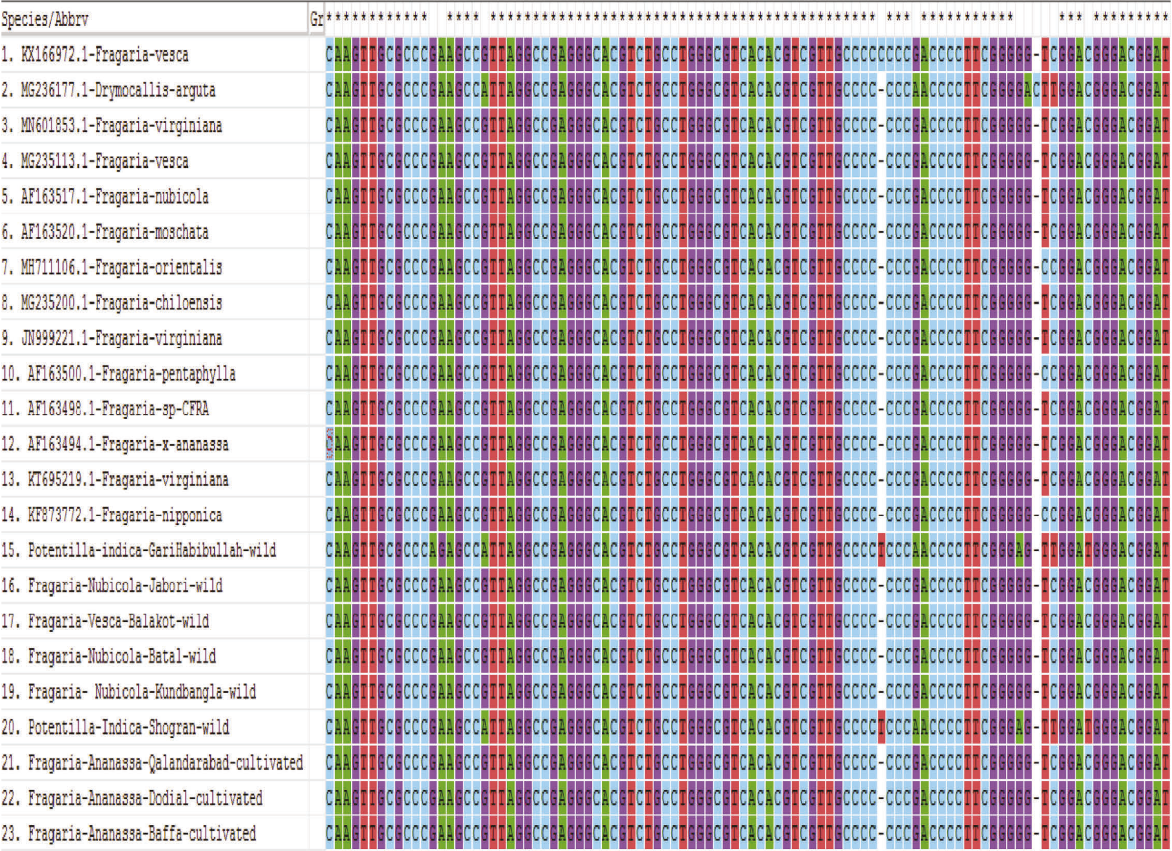
Figure 10: Alignment of Fragaria species sequences by the ITS2 marker with related reference species.